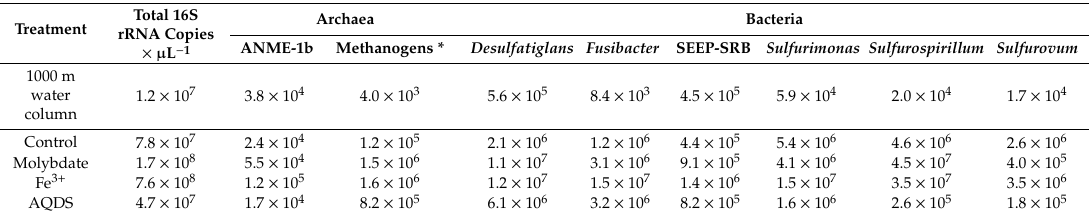
Table 1. Abundance (16S rRNA copies per L) of major species in the incubation experiments and the Black Sea water column.